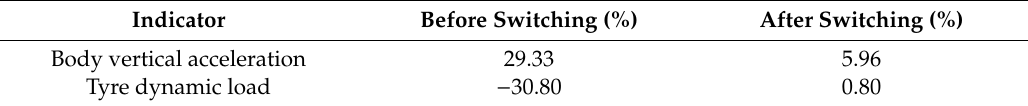
Table 4. Comparison of dynamic performance improvement before and after the mode